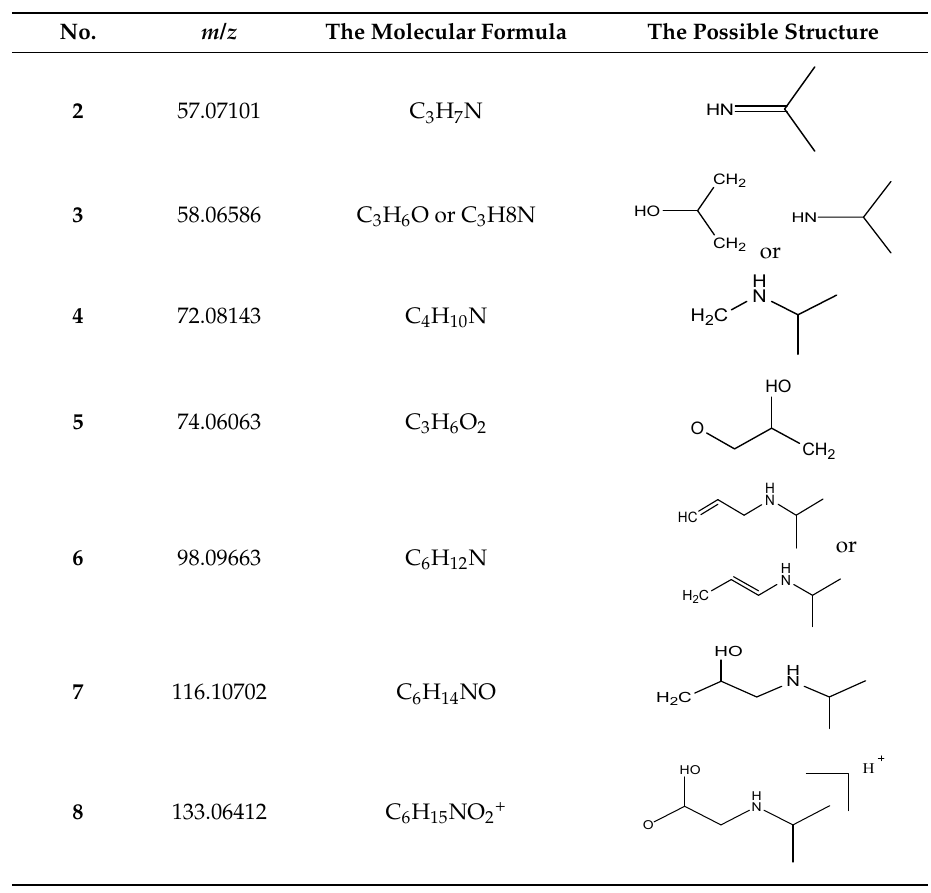
Table 2. The possible structure of corresponding characteristic fragments.